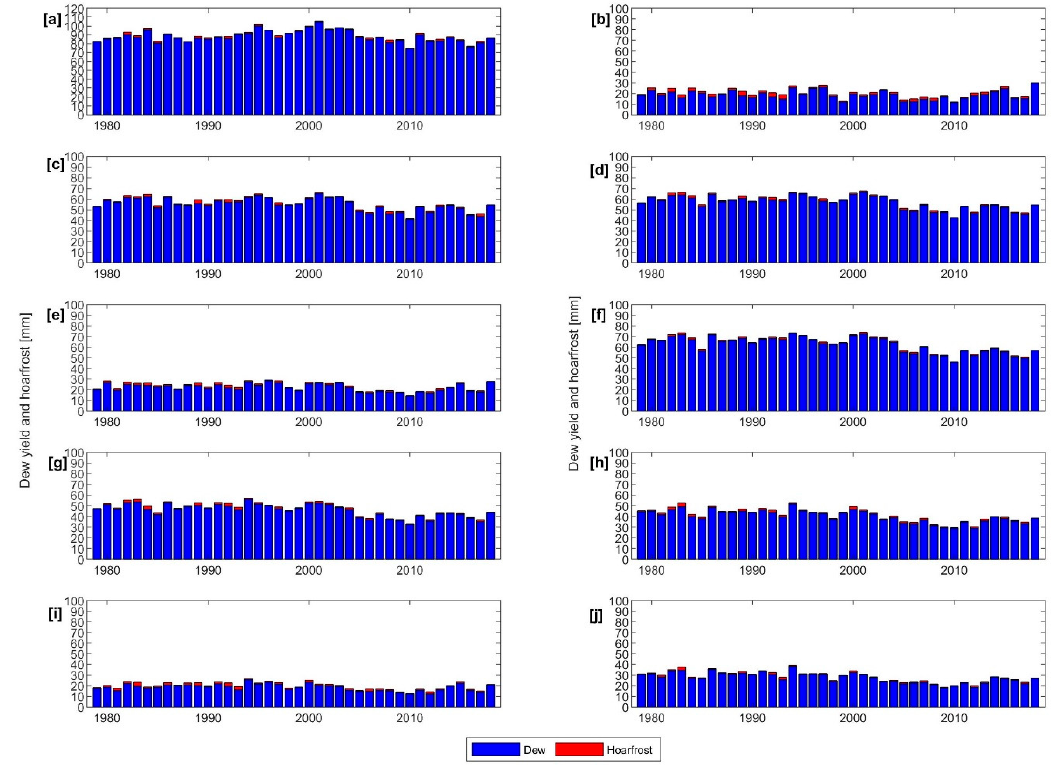
Figure 2. Yearly cumulative dew yield and ice (i.e., hoarfrost) during 1979–2018 at the selected sites: ( a ) Irbid, ( b ) Mafraq, ( c ) Amman, ( d ) Madaba, ( e ) Azraq, ( f ) Dead Sea, ( g ) Karak, ( h ) Petra, ( i ) Ma’an, ( j ) Aqaba. The subplots are in sequential order according to site number from 1 to 10 (Figure 1).